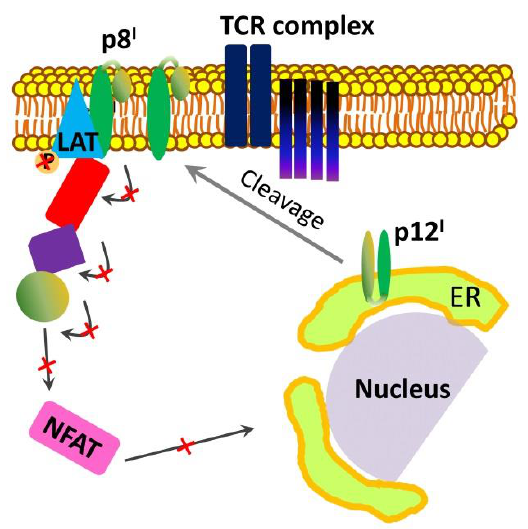
Figure 3. p8 I inhibits T cell receptor (TCR) signal transduction and NFAT activation: p8 I is a proteolytic product of p12 I in the ER membranes, the protein traffics to plasma membrane and localizes in the immunological synapse; p8 I interacts with and inhibits the phosphorylation of the transmembrane protein called linker for activation of T cells (LAT) and by doing so, p8 I disables LAT to transmit signals from TCR and to interact with other proteins, such as phospholipase C gamma 1, Vav proteins, and lymphocyte-specific protein tyrosine kinase (shown in red, cyan and green) on the TCR signaling pathway.